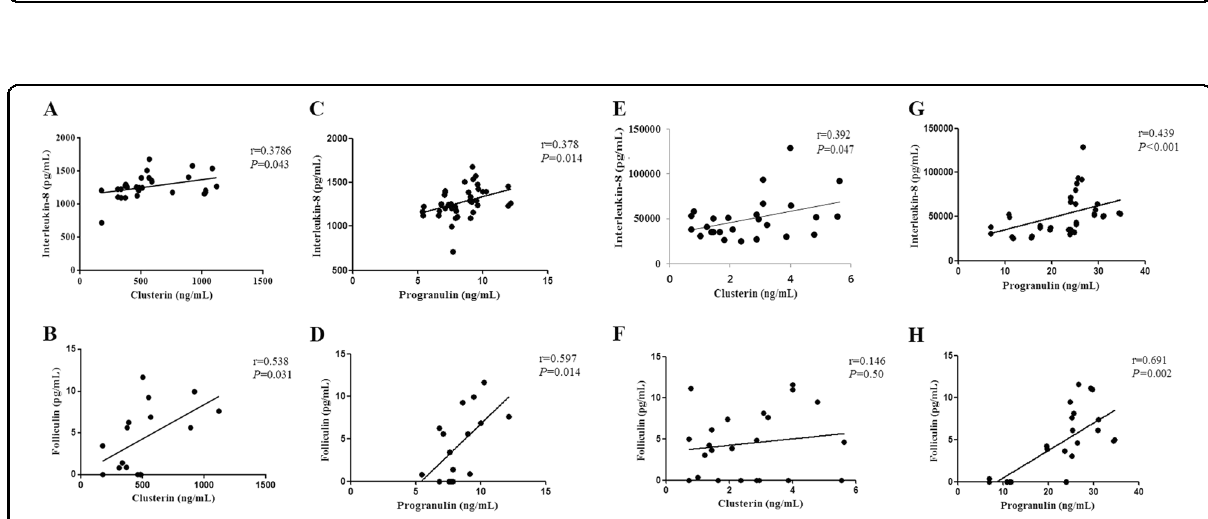
Fig. 4 Correlation of clusterin/progranulin levels with the levels of IL-8 and folliculin produced by human airway epithelial cells after TDI exposure. Correlations between clusterin/progranulin and IL-8 and FLCN in cell-free supernatants collected from A549 cells ( a – d ) and SAECs ( e – h ) were analyzed by calculating Pearson ’ s correlation coef fi cient. HAECs human airway epithelial cells, SAECs small airway epithelial cells, FLCN